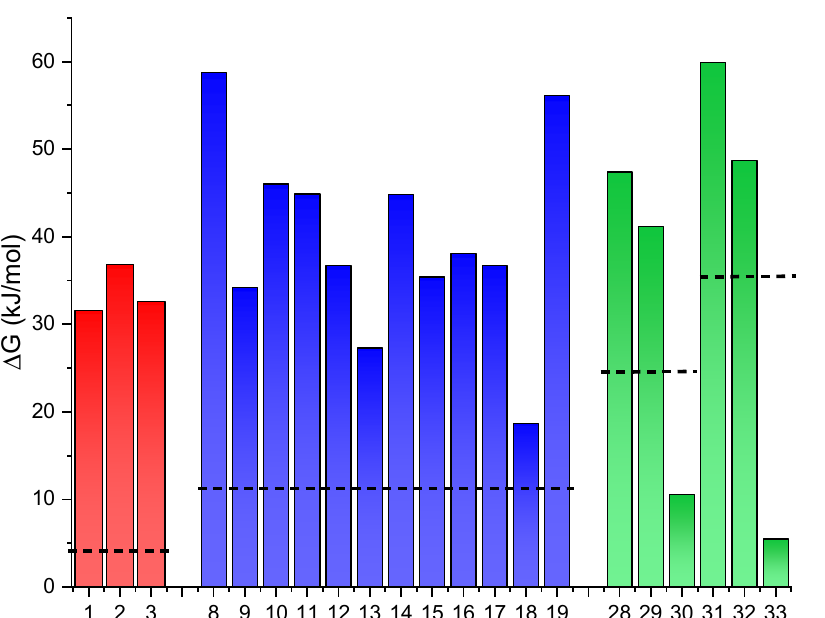
Figure 3. Energy difference between isomers in locked photoswitches ( 1 – 3 hydantoins, 8 – 19 oxazolones, 28 – 33 rhodopsin-based neutral and protonated). The dashed line represents the non-restrained system in each case. In 8 – 19 and 28 – 33 the most stable is the Z -isomer contrary to the parent molecule, and only in 1 – 3 is the E -isomer more stable.